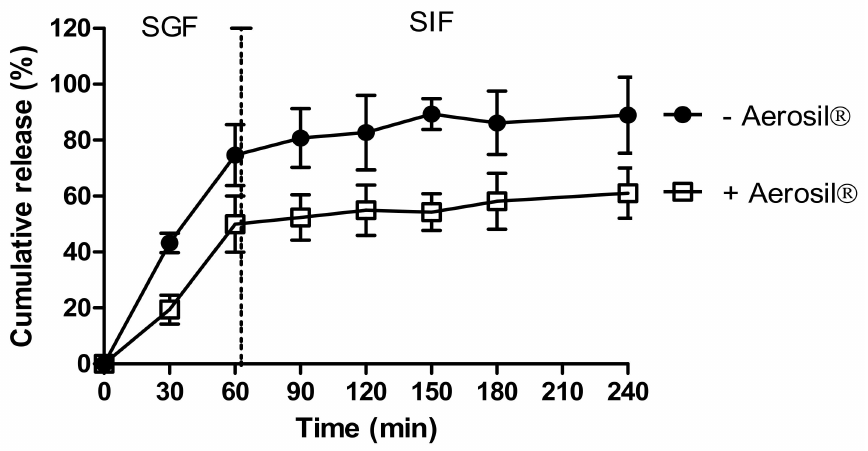
Figure 2. The effect of drying methods on insulin release from dWPI beads. Each point represents mean ± SD ( n = 3; + Aerosil ® ), ( n = 2; − Aerosil ® ).